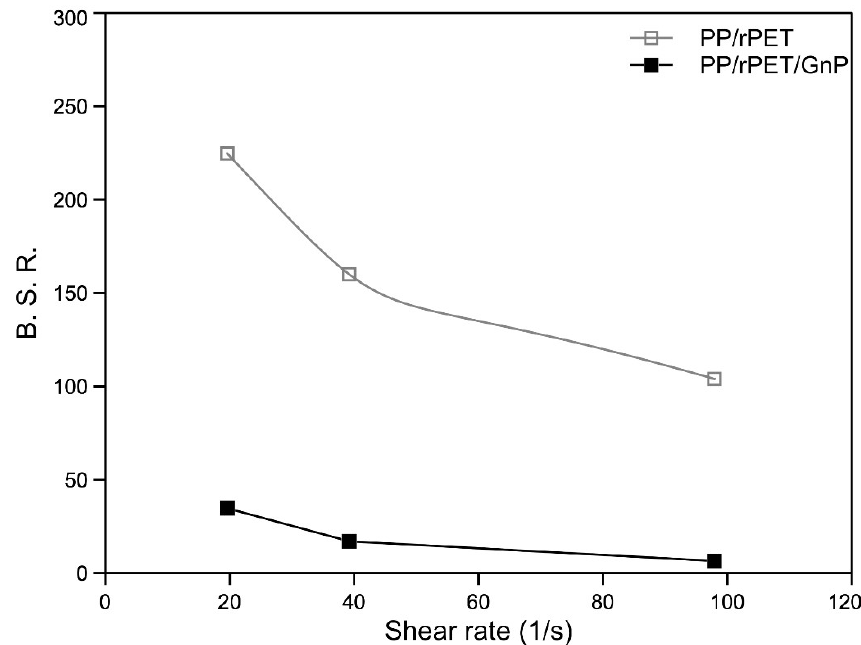
Figure 4. Breaking stretching ratio (BSR) as function of the shear rate of the two systems.